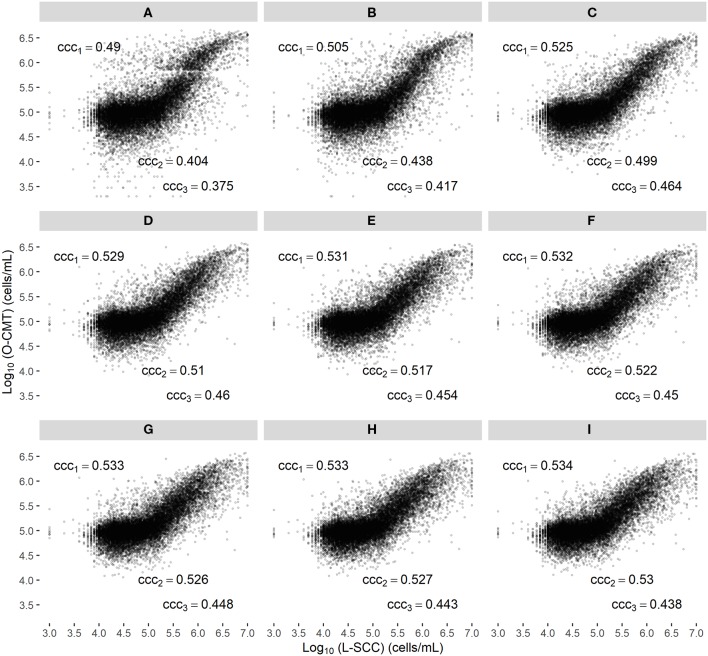
Scatter plot of the log10-transformed online CMT (O-CMT) values for randomly sampled one O-CMT records on DHI test dates against log10-transformed laboratory measured SCC (L-SCC) (A) and the average of multiple O-CMT within different time windows against L-SCC (B–I, corresponding to time windows from 0 to 168 h, increasing by steps of 24 h); ccc1 represents the overall concordance correlation coefficient between log10-transformed O-CMT and log10-transformed L-SCC, ccc2 is the concordance correlation coefficient with L-SCC within the range of 100,000–1,500,000 cells/mL and ccc3 is the concordance correlation coefficient with L-SCC in range of 200,000–9,999,000 cells/mL. Farms with ≥ 100 DHI tests with valid SCC results measured by O-CMT and L-SCC were included.